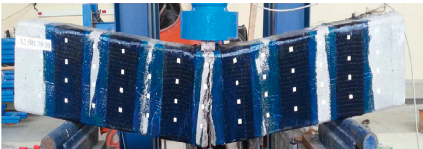
Figure 12: Experimental crack patterns at failure load for beam A2.5RC10/10.